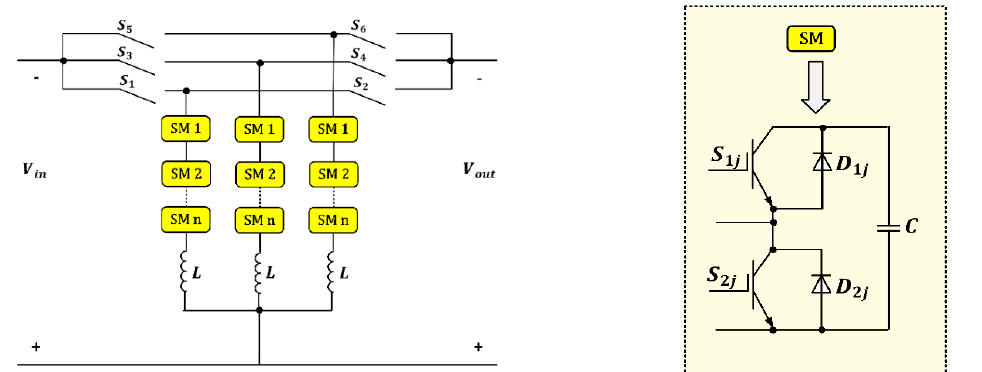
Figure 8. MVDC Auto-Transformer (MVDC-AT) converter circuit diagram.